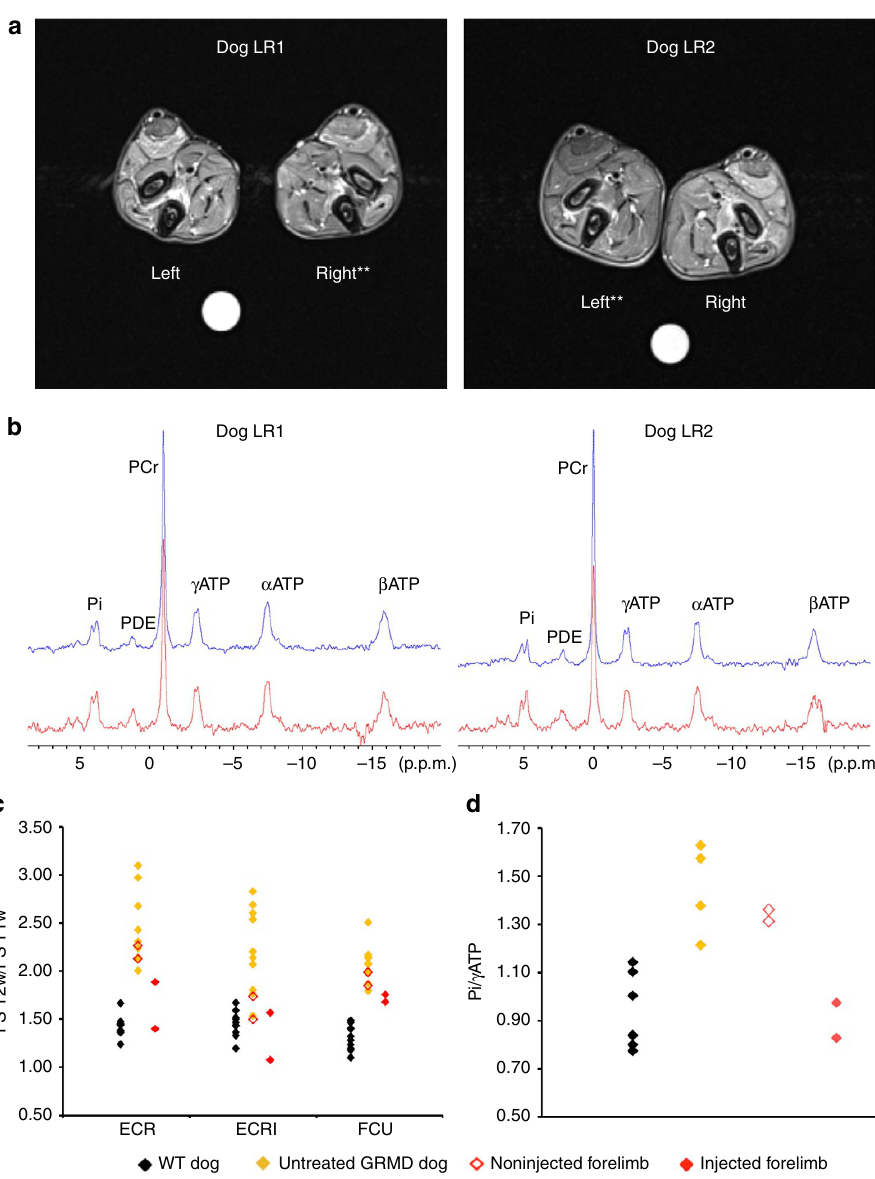
Figure 3 | NMR imaging and spectroscopy analyses of muscles of GRMD dogs injected with rAAV2/8-Spc5.12-cMD1 by the LR route. ( a ) Representative example of transverse fat-saturated T2-weighted NMR image of the two forelimbs obtained in dog LR2. At 3 months after injection, signal muscle intensities were decreased and more homogeneous in the injected forelimb (**) compared with the noninjected one. ( b ) Representative example of 31 P-NMR spectra of the injected (blue curve) and noninjected forelimb (red curve) of the same dog (LR2). Phosphocreatine (PCr) was increased and inorganic phosphates (Pi) and phosphodiesters (PDE) were decreased relative to ATP in the injected forelimb compared with the noninjected forelimb. ( c ) NMR imaging fat-saturated (FS) T2w/T1w muscle signal ratio obtained from three different muscles (ECR ( extensor carpi radialis brevis ), ECRl ( extensor carpi radialis longus ) and FCU ( flexor carpi ulnaris )). The values of this index in the injected forelimb (red closed symbols) were decreased compared with the values obtained in the noninjected forelimb (open red symbols) or in untreated GRMD dogs (yellow symbols), and they were closer to the healthy dog (WT) indices (black symbols). ( d ) NMR spectroscopy Pi/ g ATP muscle signal ratios of the injected (red closed symbols) and noninjected forelimbs (open red symbols) as compared with untreated GRMD (yellow symbols) and healthy (WT) controls (black